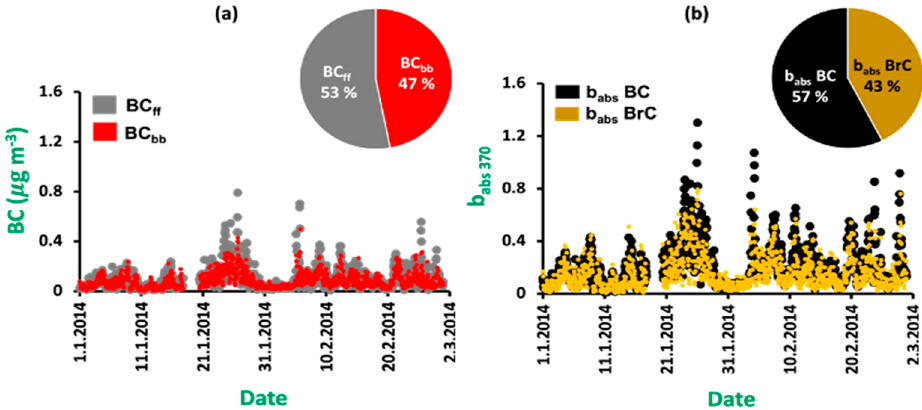
Figure 4. Time series and contributions of the hourly average BC ff and BC bb to the total BC ( a ), as well as b abs BrC and b abs BC to the total b abs (Mm − 1 ) ( b ).